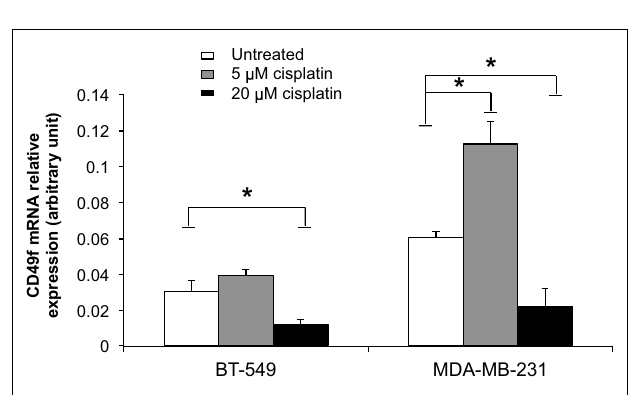
FIGURE 6 | Comparison of cisplatin effect on mRNA expression of CD49f, a stem cell marker, at low and high cisplatin doses in breast cancer cells . Individual PCR reactions were normalized against internal positive control ( β -actin) and plotted as the mRNA relative expression for both untreated and cisplatin-treated BT-549 and MDA-MB-231 breast cancer cells. Cells were incubated with 5 and 20 µ M cisplatin for 24h. Experiments were done in duplicates in three independent experiments. Bars are presented as mean ± SEM. * p ≤